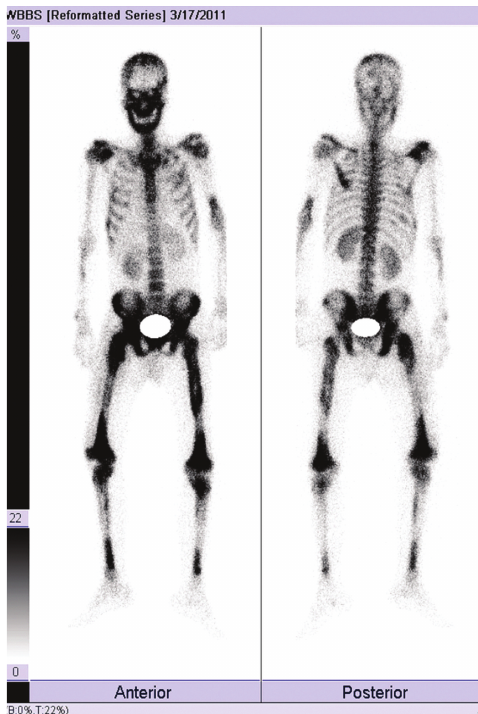
Figure 4: Tc-99m MDP WBBS of the second admission 2 years later showed multiple bone involvement observed as similar to those found in the previous Tc-99m MDP WBBS except the increased radioactive accumulation in fractured right femur.